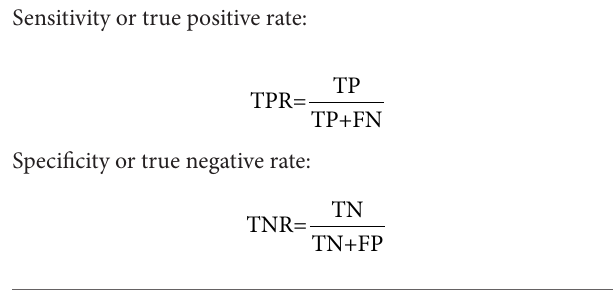
TaBle 1 | The number of patients and nodules they carry for nodule versus non-nodule groups.